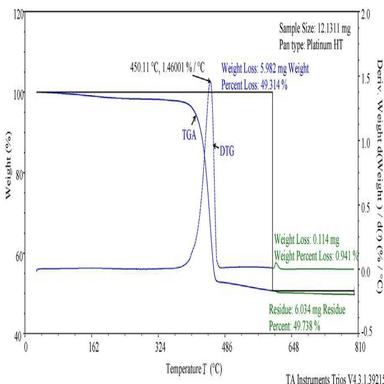
TG/DT analysis on non-welded region.